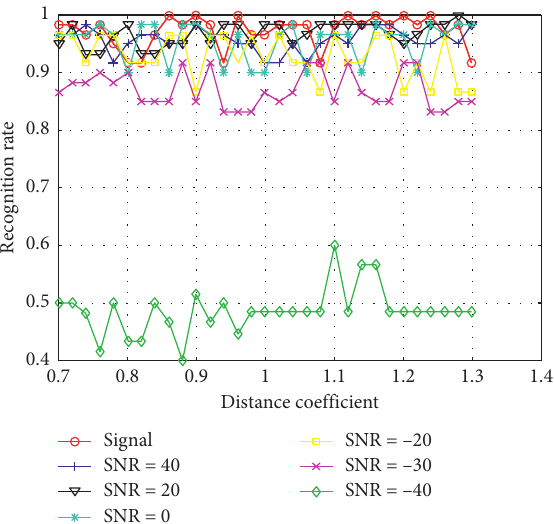
Figure 5: Fault recognition rate under the different noise levels and distance coefficients.